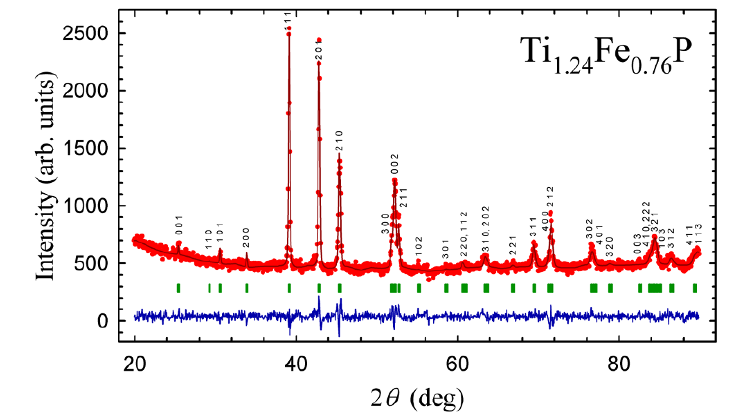
Figure 4. Observed ( ۰ ) calculated (-) and difference X-ray diffraction patterns of the TiFeP. The hkl indices are indicated.